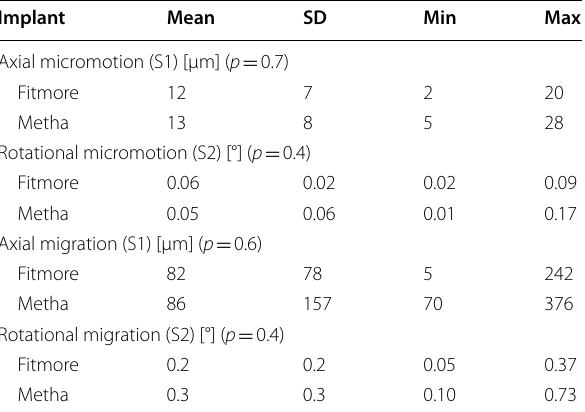
Table 2 Measurements of reversible micromotion